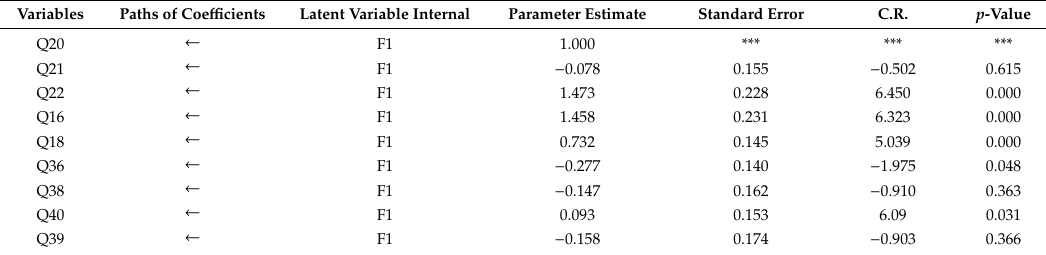
Table 6. Confirmatory factor analysis of INTERNAL.